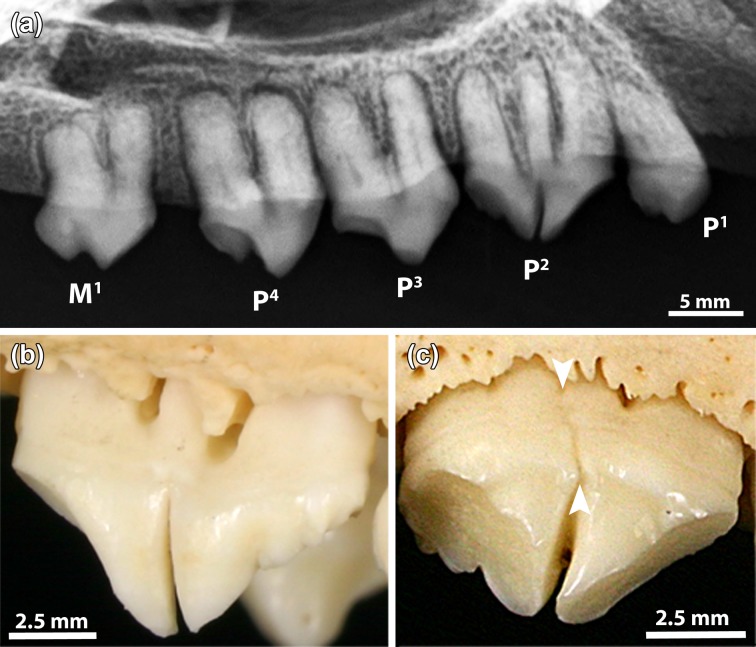
Abnormal crown and root morphology in an 11-year-old female Eastern Atlantic harbor seal (Phoca vitulina vitulina, specimen ZIK 29115), diagnosed as a case of gemination.(a) Radiograph (mediolateral projection) of left maxillary postcanine tooth row. Note bifid crown and occurrence of three roots in the P2, and presence of a small supernumerary root arising from the bifurcation area in the P3. (b) Buccal view of left P2. Buccally, the notch in the tooth crown does not extend onto the central root. (c) Palatal view of left P2. Palatally, the notch extends onto the central root. Arrowheads: vertical furrow on the central root.